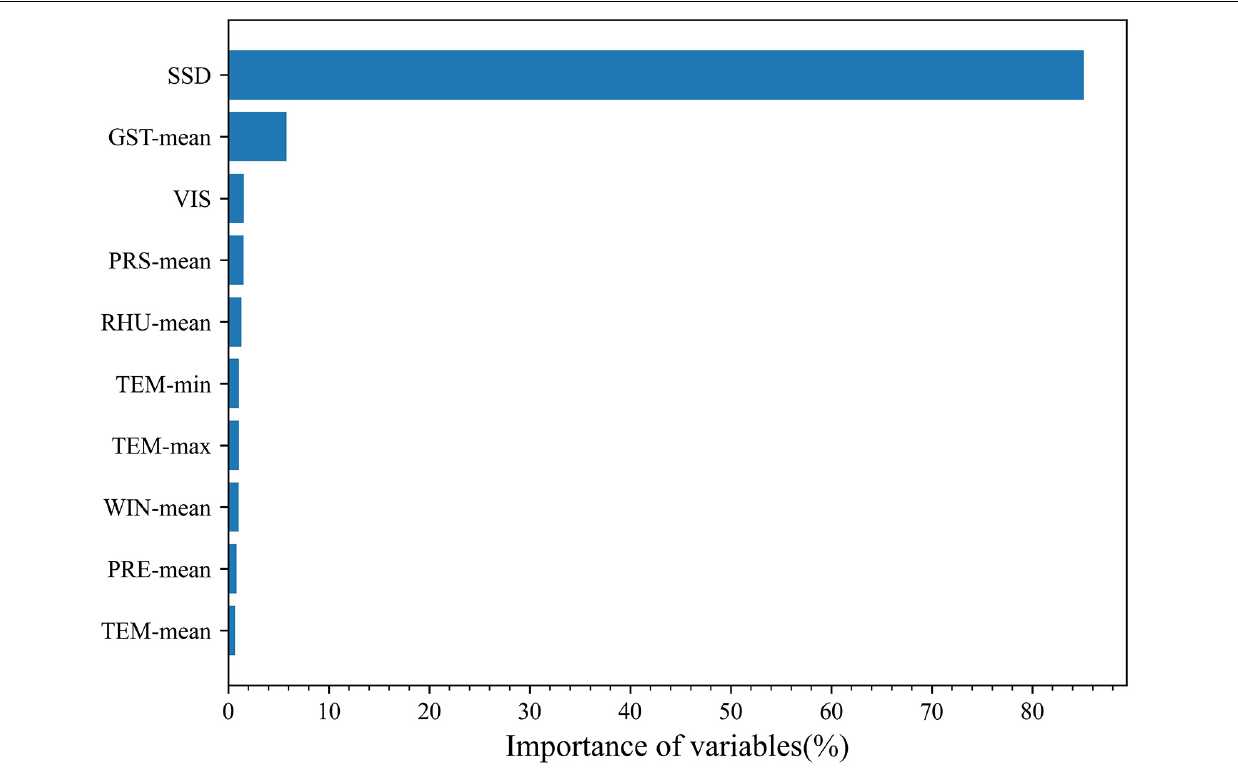
Frontiers in Earth Science |